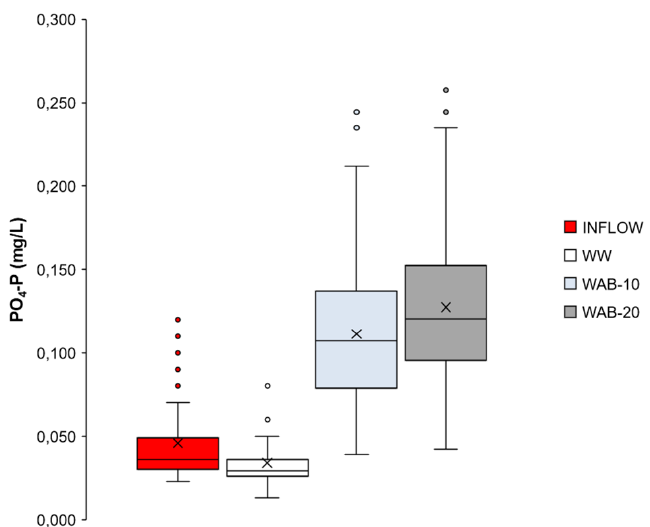
Figure 5. Comparison of PO 4 -P concentrations at the outlets of the bioreactors. The specific compo- nents in the graphs are the same as in Figure 2.